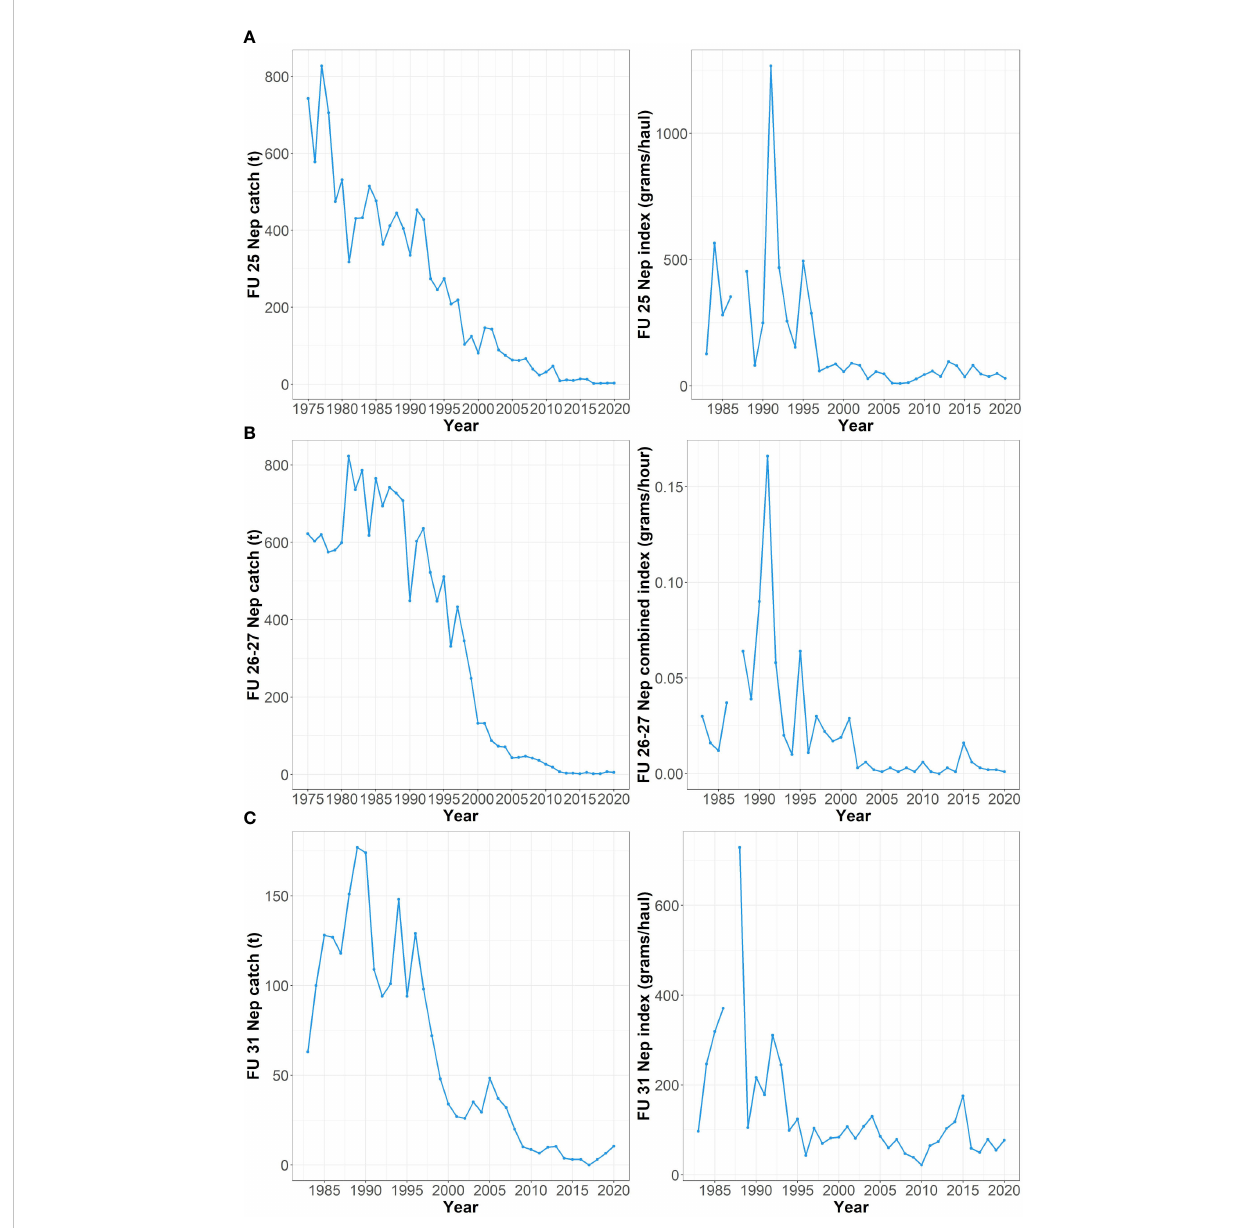
FIGURE 2 Nephrops catches and surveys biomass indices. FU 25 (North Galicia) (A) , FU 26-27 (West Galicia and North Portugal) (B) and FU 31 (Cantabrian Sea) (C) . In 1987 there was no survey. FU 25 (North Galicia) index 1991 data was deleted for the